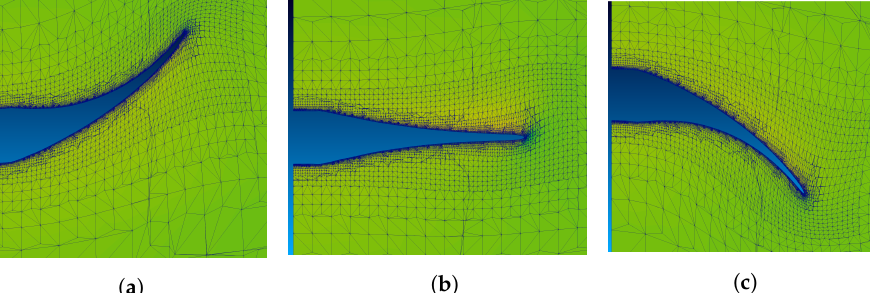
Figure 11. Deformable mesh in different positions: fin at the upper extremity of its motion ( a ), fin in the middle of its motion ( b ), fin at the lower extremity of its motion ( c ).